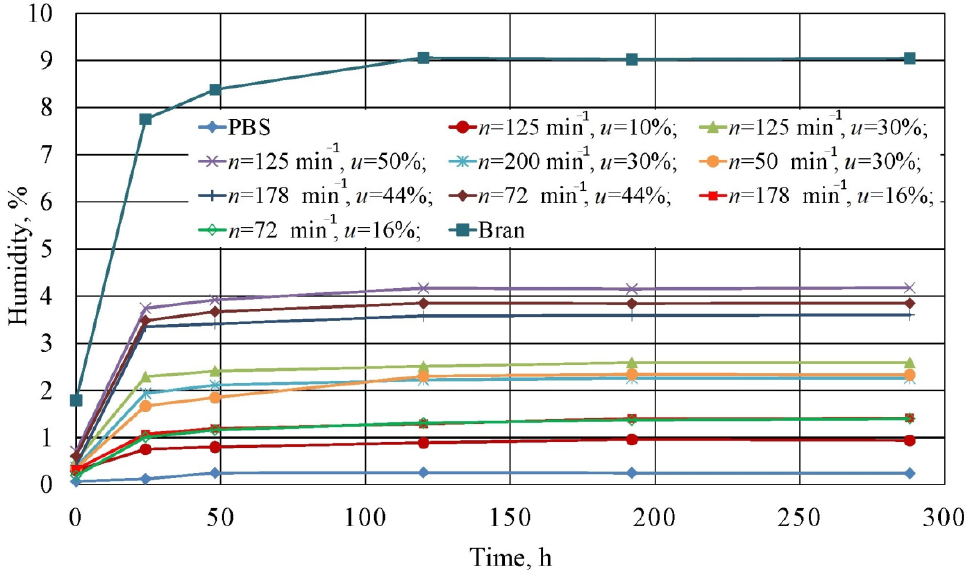
Figure 23. Relationship between the moisture absorbed by the tested blends, PBS and wheat bran itself from air and the exposure time.